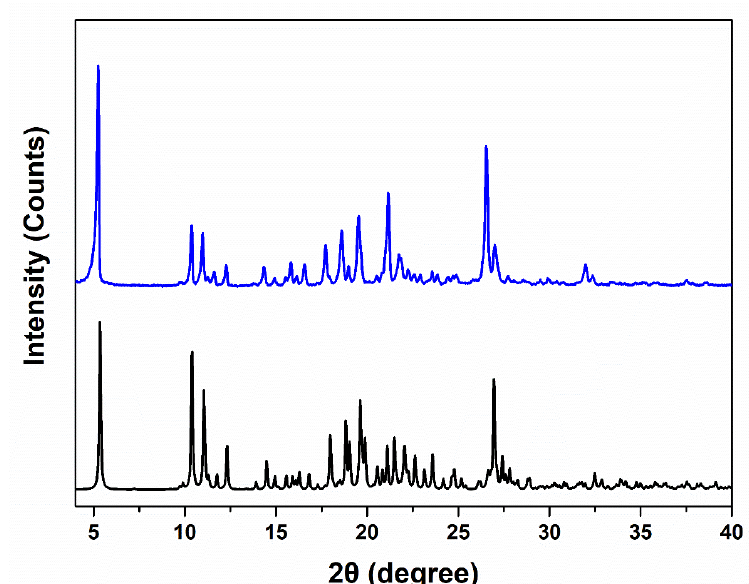
Figure 2. The powder X-ray diffraction (PXRD) patterns of 2 showing a good consistency between the experimental one (blue) and that simulated (black) from single-crystal diffraction data, and thus a high phase purity for 2 . Where 2 θ is the angle between transmitted X-ray beam and reflected beam.